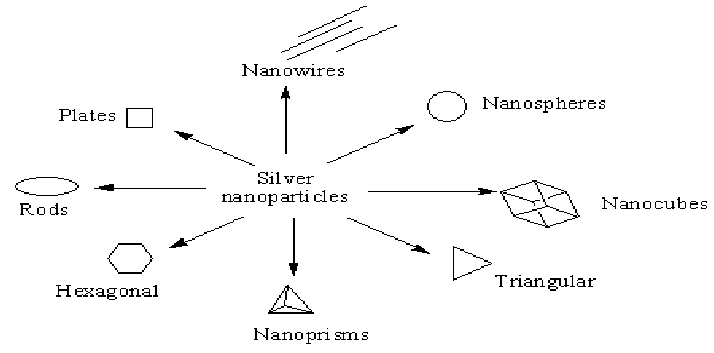
Figure 3. Nanoshapes of silver nanoparticles.